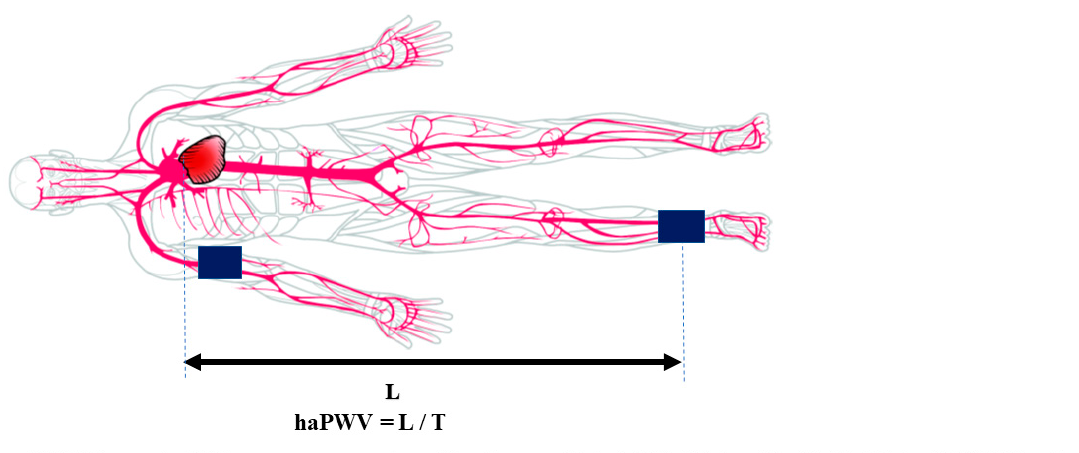
Figure 3. Principles of the cardio-ankle vascular index (CAVI). CAVI is an index derived from arterial intraluminal volumetric change by combining stiffness parameter β and Bramwell-Hill formula. Heart-ankle pulse wave velocity (haPWV) is obtained by dividing L (the length from the aorta to the ankle) by T (the time for the pulse wave to propagate from the aortic valve to the ankle). CAVI: cardio-ankle vascular index, haPWV: heart-ankle pulse wave velocity, Ps: systolic blood pressure, Pd: diastolic blood pressure, Δ P is pulse pressure (Ps-Pd), ρ : blood density of 1.05 g/mL. a and b are constants.